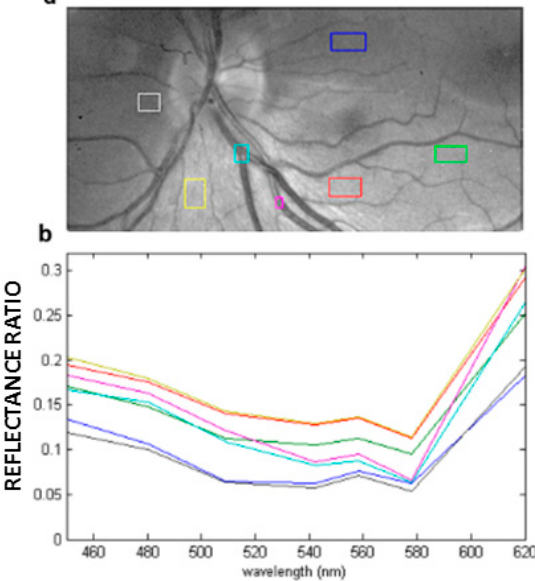
Figure 4. Reflectance spectra of different retinal regions: ( a ) MSI ocular fundus image at 542 nm, ( b ) corresponding reflectance spectra of different regions in the retina (coloured squares correspond to coloured lines). Reflectance shows troughs at 542 and 578 nm corresponding to the absorbance peaks of HbO 2 as shown in Figures 2a and 5.